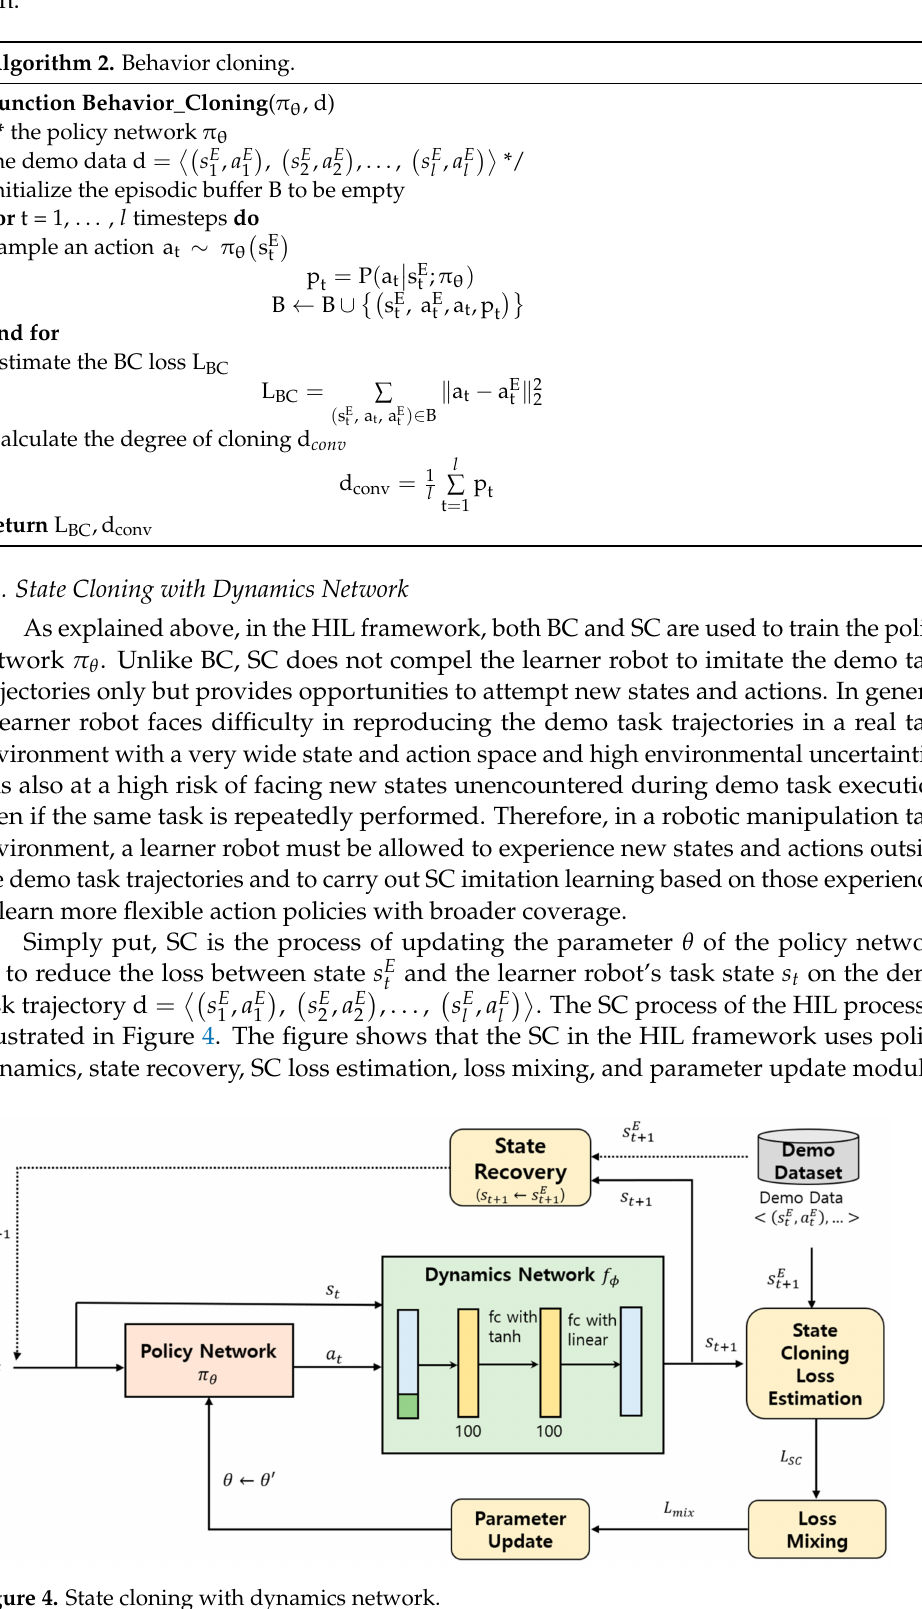
Figure 4. State cloning with dynamics